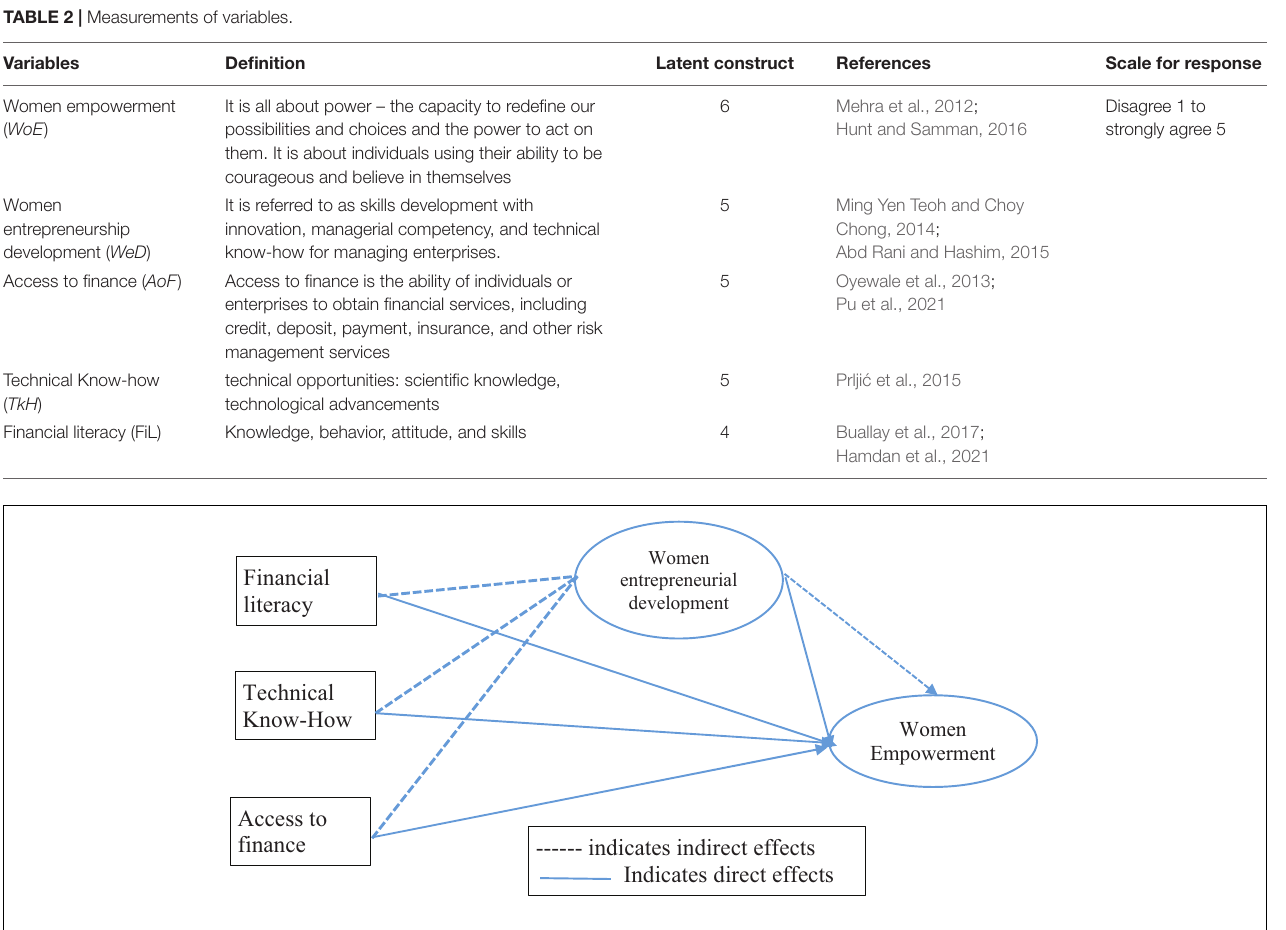
FIGURE 1 | Conceptual framework women empowerment through entrepreneurship in